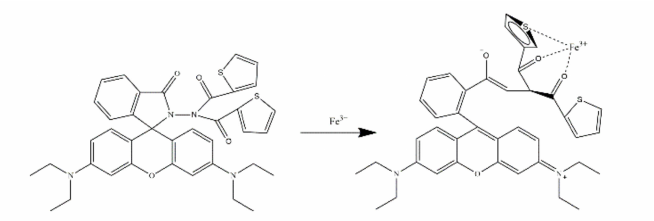
Figure 20. The proposed sensing mechanism of the prepared sensor (Table 1, No. 26) to Fe 3+ [55]. Wang K. P., et al. (Table 1, No. 27) reported a Fe 3+ -detecting fluorescence sensor, BYY, synthesized by the reaction of 2-thiopheneacetic acid and N-(rhodamine-B)lactam- ethylenediamine [56]. The BYY sensor exhibited high sensitivity toward Fe 3+ in EtOH/H 2 O (2/3, v / v , pH = 7.2) with a fast response rate. Owing to a strong affinity between Na 4 P 2 O 7 and Fe 3+ , BYY realized the reversible binding of Fe 3+ (Figure 21). BYY was successfully applied for the bio-imaging of Fe 3+ in living